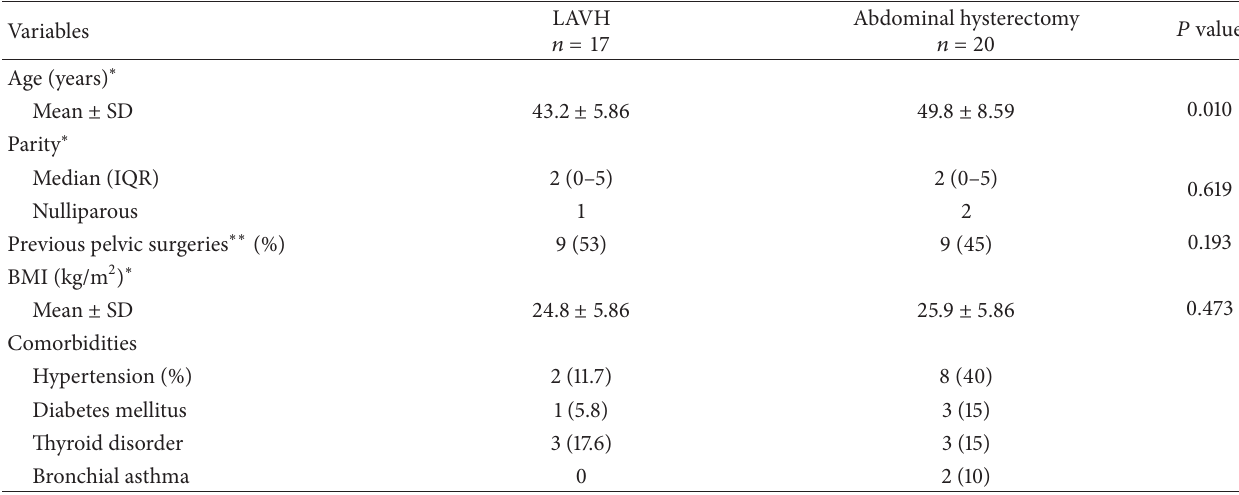
Table 1: Demographic characteristics of the studied